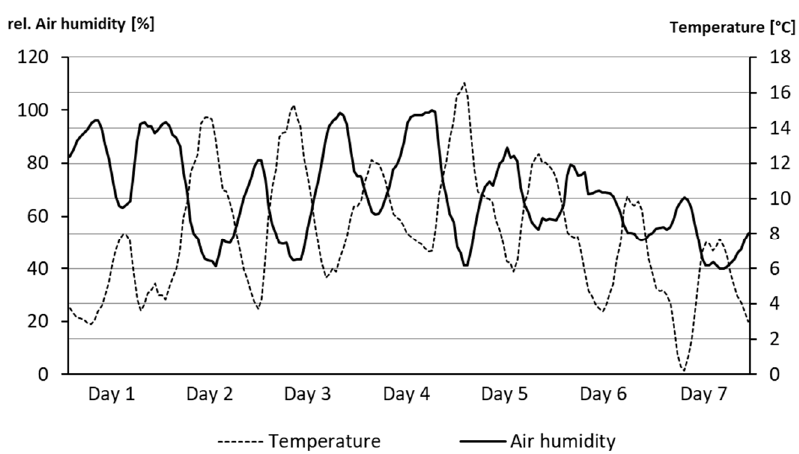
Figure 5. Display of the air temperature (°C) and relative humidity (%) during the test week (LWF).